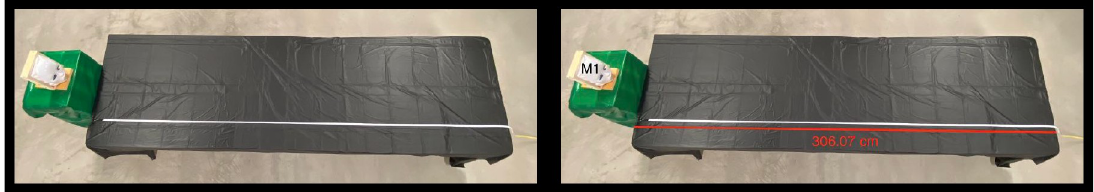
Fig 3. Frontal droplet spread when sitting simulation. A white metric measuring tape with centimeter and millimeter markings is displayed in each figure. (A) A bird’s eye view photo of the full table in front of the mannequin simulating the cough is shown. (B) The exact measurement of the table is labeled, and the mannequin is labeled as